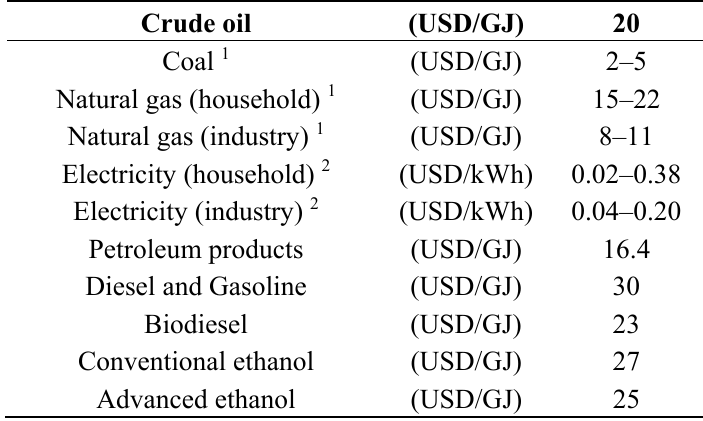
Table A2. Assumed international energy prices in year